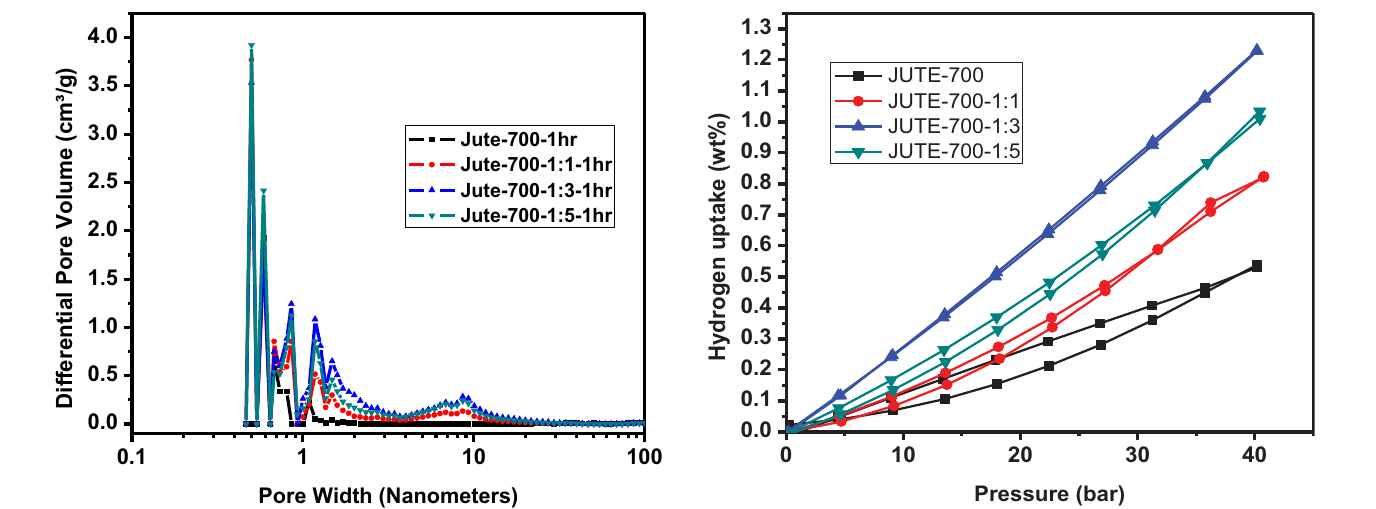
Fig. 6. Hydrogen uptake in activated carbon as a function of equilibrium pressure at 30 ° C. Activated carbon weight = 100mg.